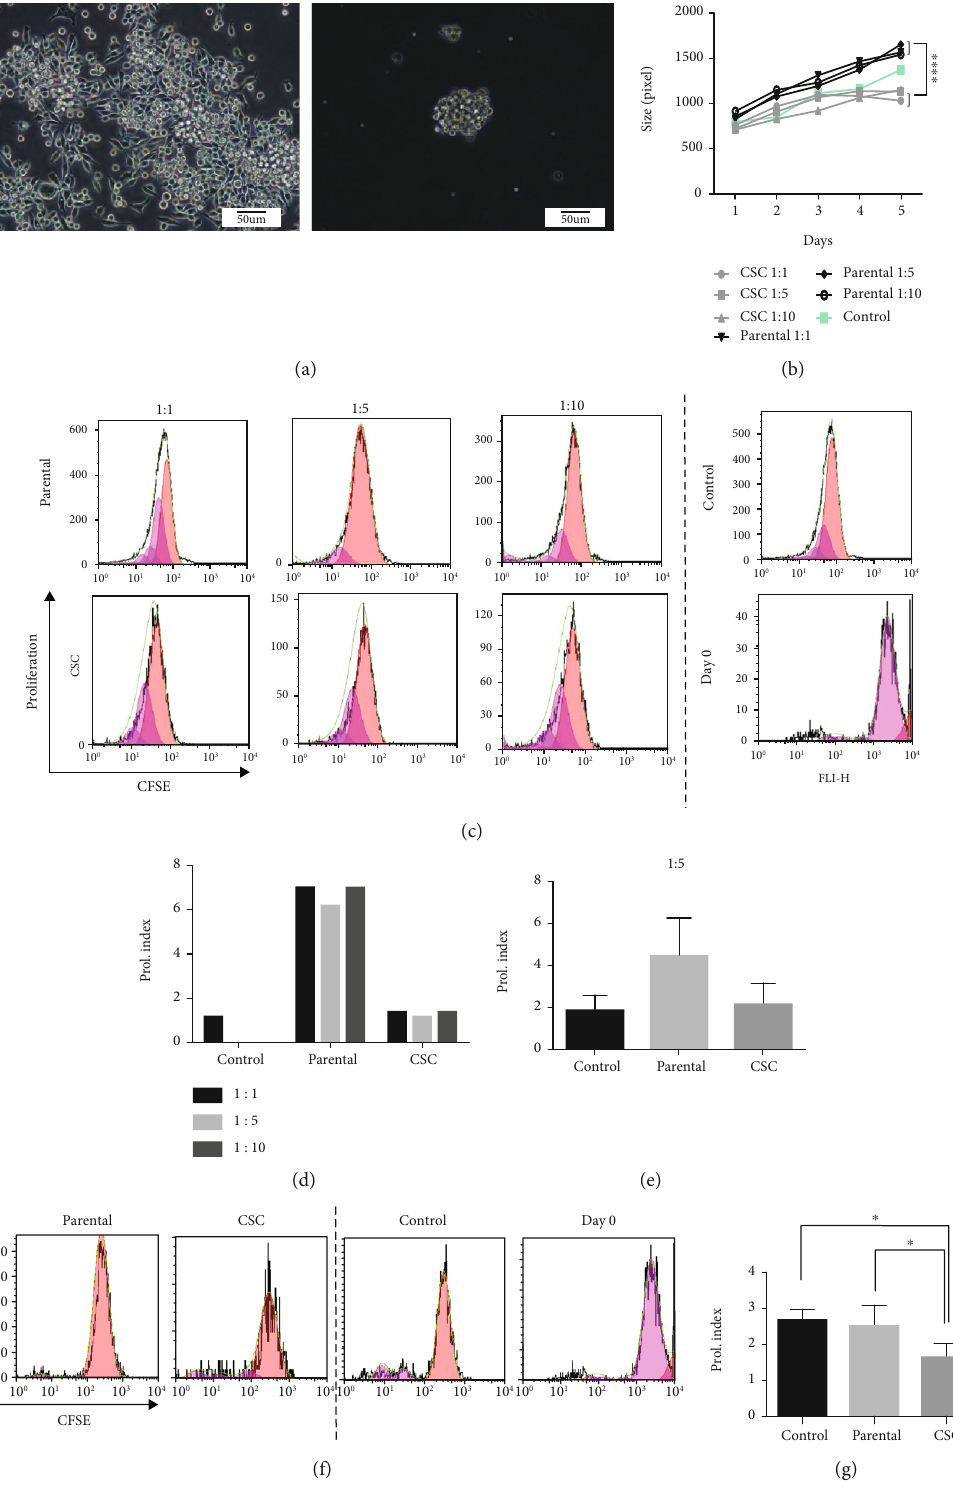
Figure 1: Gastrospheres ’ conditioned medium limits PBMC proliferation. (a) Monolayer culture of MKN-45 gastric cancer cell line and its derived-loose grape-like shape gastrospheres. (b) Colony size of PBMCs in exposure to MKN-45 parental cells or gastrosphere-derived conditioned media in MLR. (c, d) PBMCs ’ proliferation in exposure to parental or gastrospheres ’ conditioned media in MLR ( n = 1 ). (e) PBMCs ’ proliferation in exposure to parental or gastrospheres ’ conditioned media in MLR at ratio 1: 5. (f, g) PBMCs ’ proliferation in exposure to parental or gastrospheres ’ conditioned media in the presence of anti-CD3/CD28 microbeads at ratio 15. CSC: gastrospheres. Data are mean ± SD of three independent experiments. ∗ P < 0 : 05